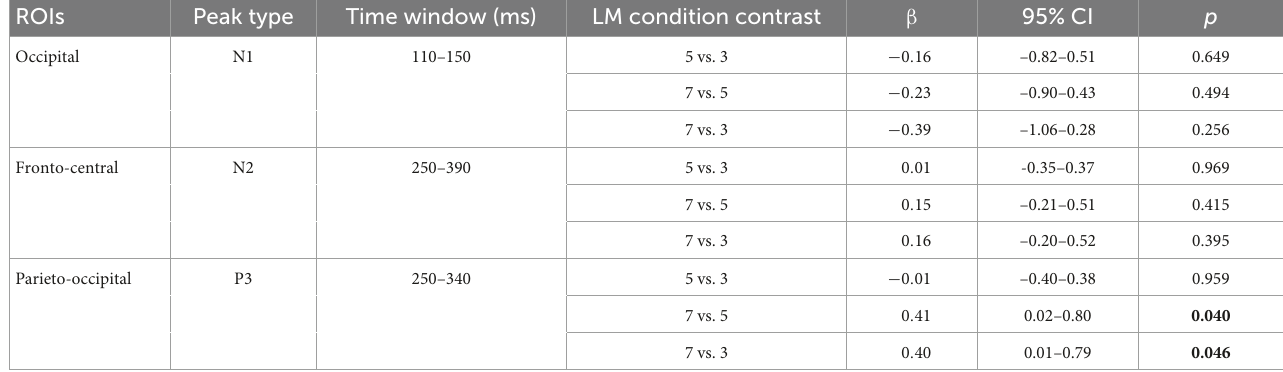
TABLE 2 Regression coefficients of peak amplitudes of the N1 at the occipital lead (Oz), N2 at fronto-central leads (Fz and FCz), and P3 at parieto-occipital leads (Pz, POz, and Oz) across pairwise contrasts of the landmark conditions. ROIs Peak type Time window (ms) LM condition contrast β 95% CI